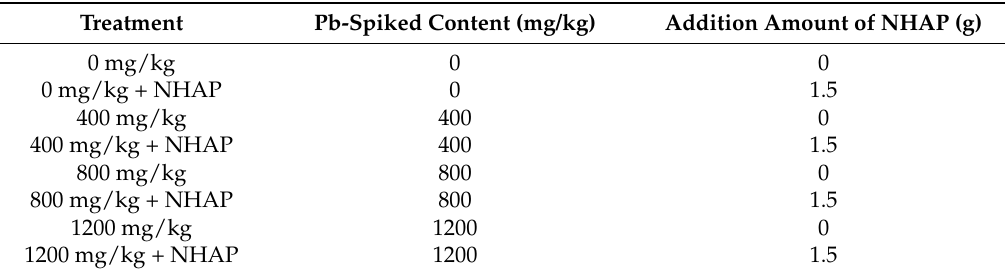
Table 1. Design of the pot experiments for the different treatments.